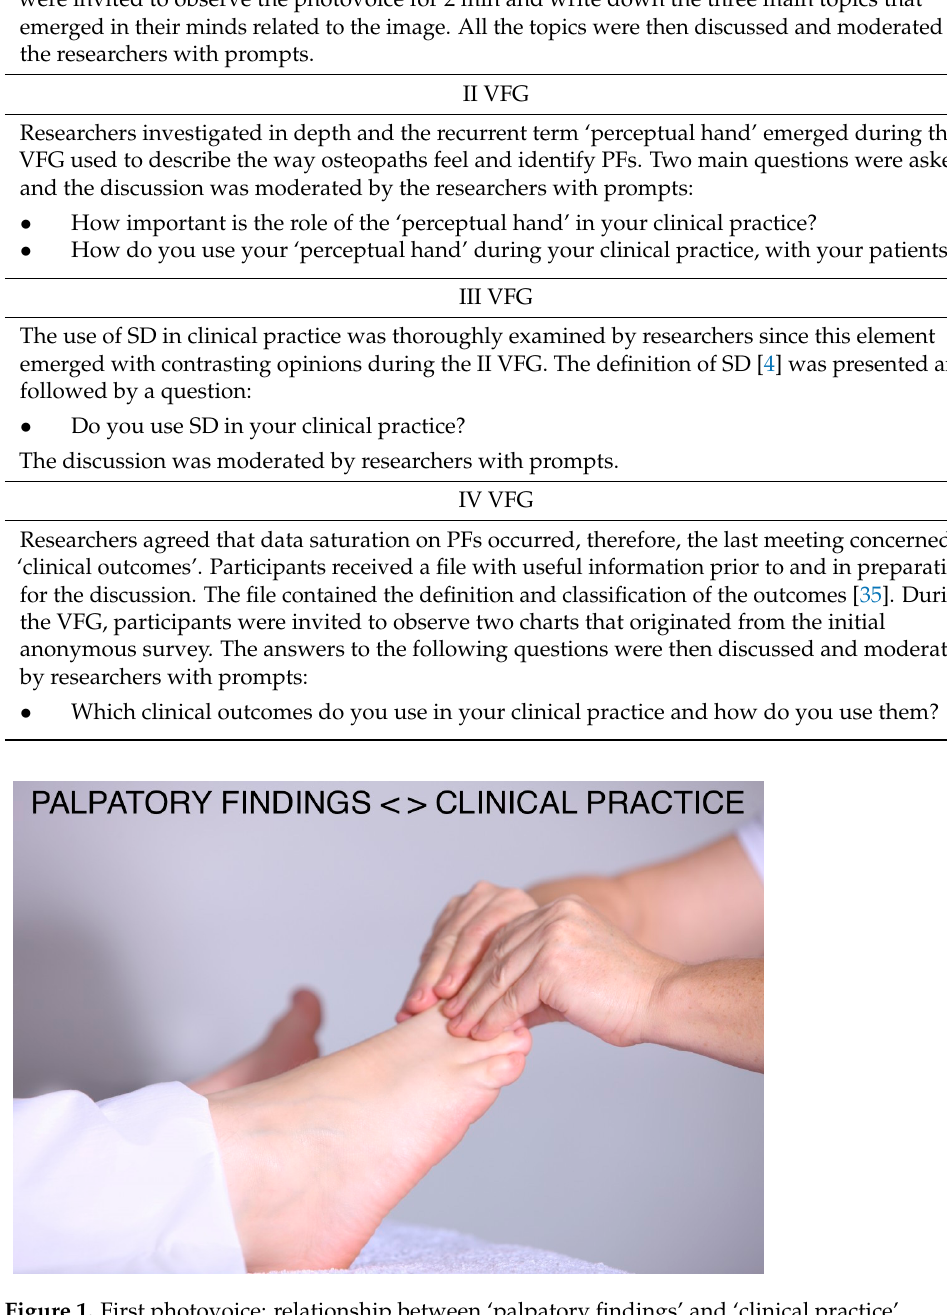
Figure 2. Second photovoice: relationship between ‘clinical outcomes’ and ‘clinical practice’. Figure 3. Third photovoice: relationship between ‘hands’ and ‘profession’.